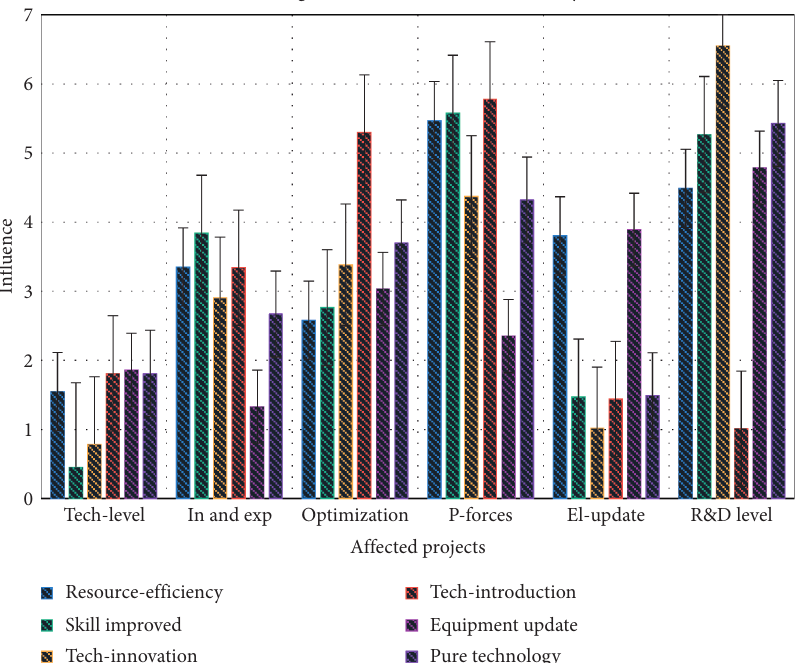
Figure 9: Relationship between changes in resource allocation